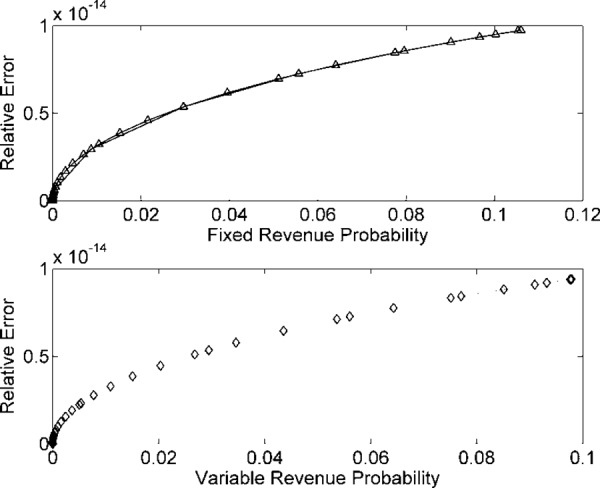
REs in RF(t) and Rv(t) for n = 109 samples.